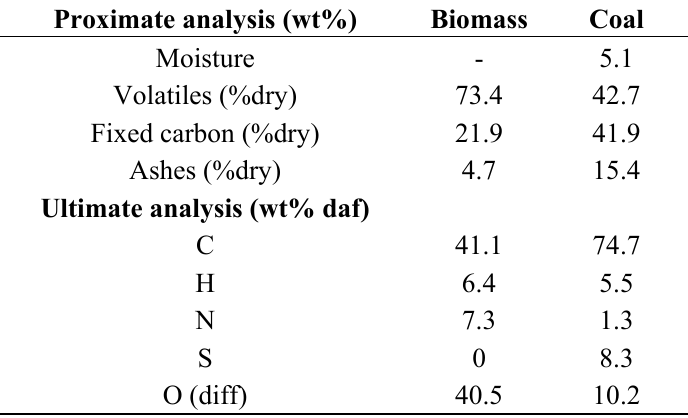
Table 1. Chemical and physical properties of Chlorella vulgaris biomass and Sulcis